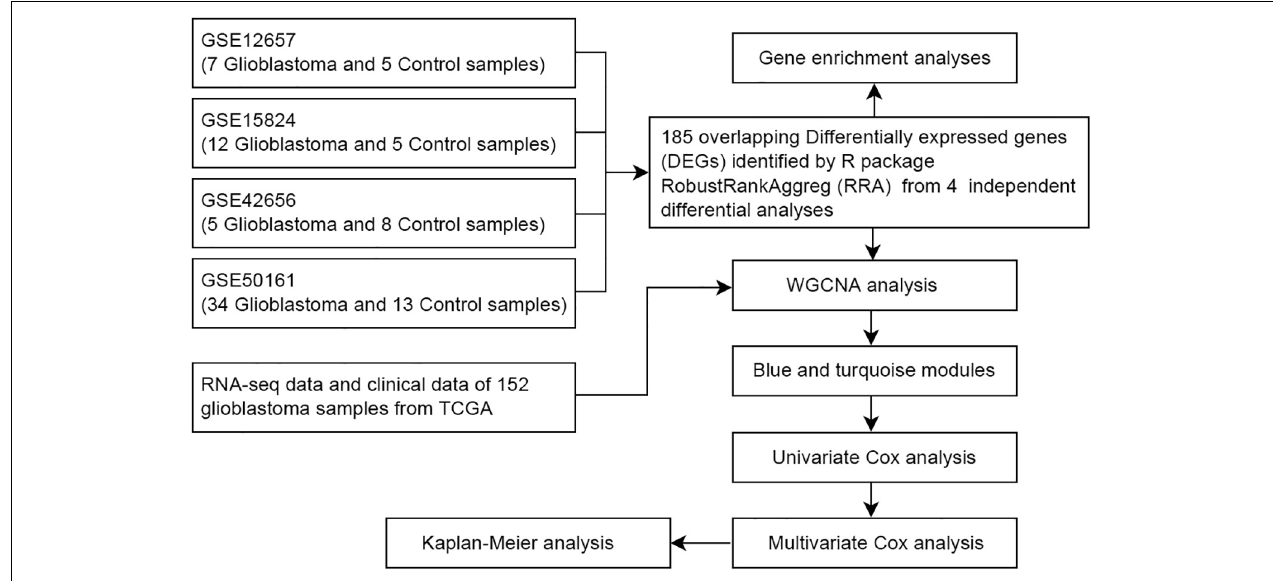
FIGURE 1 | Flow chart of data collection and analysis.